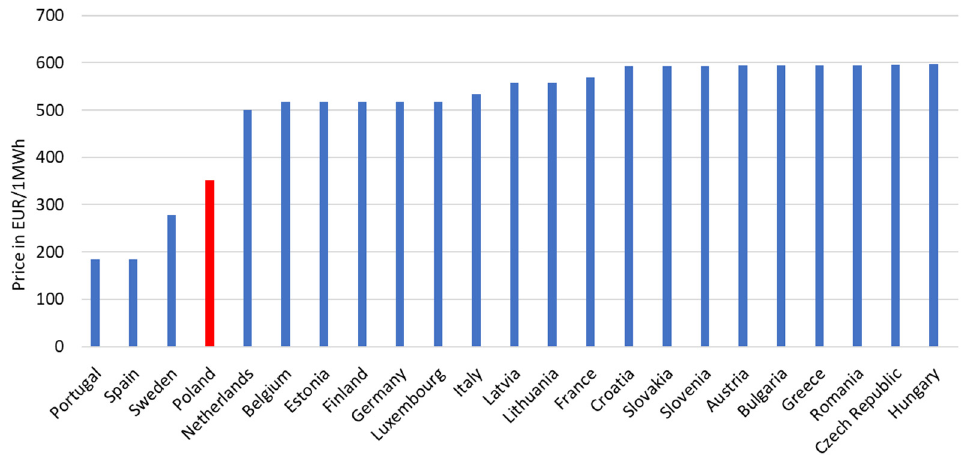
Figure 8. Electricity prices in selected EU countries (as of August 2022) [50].